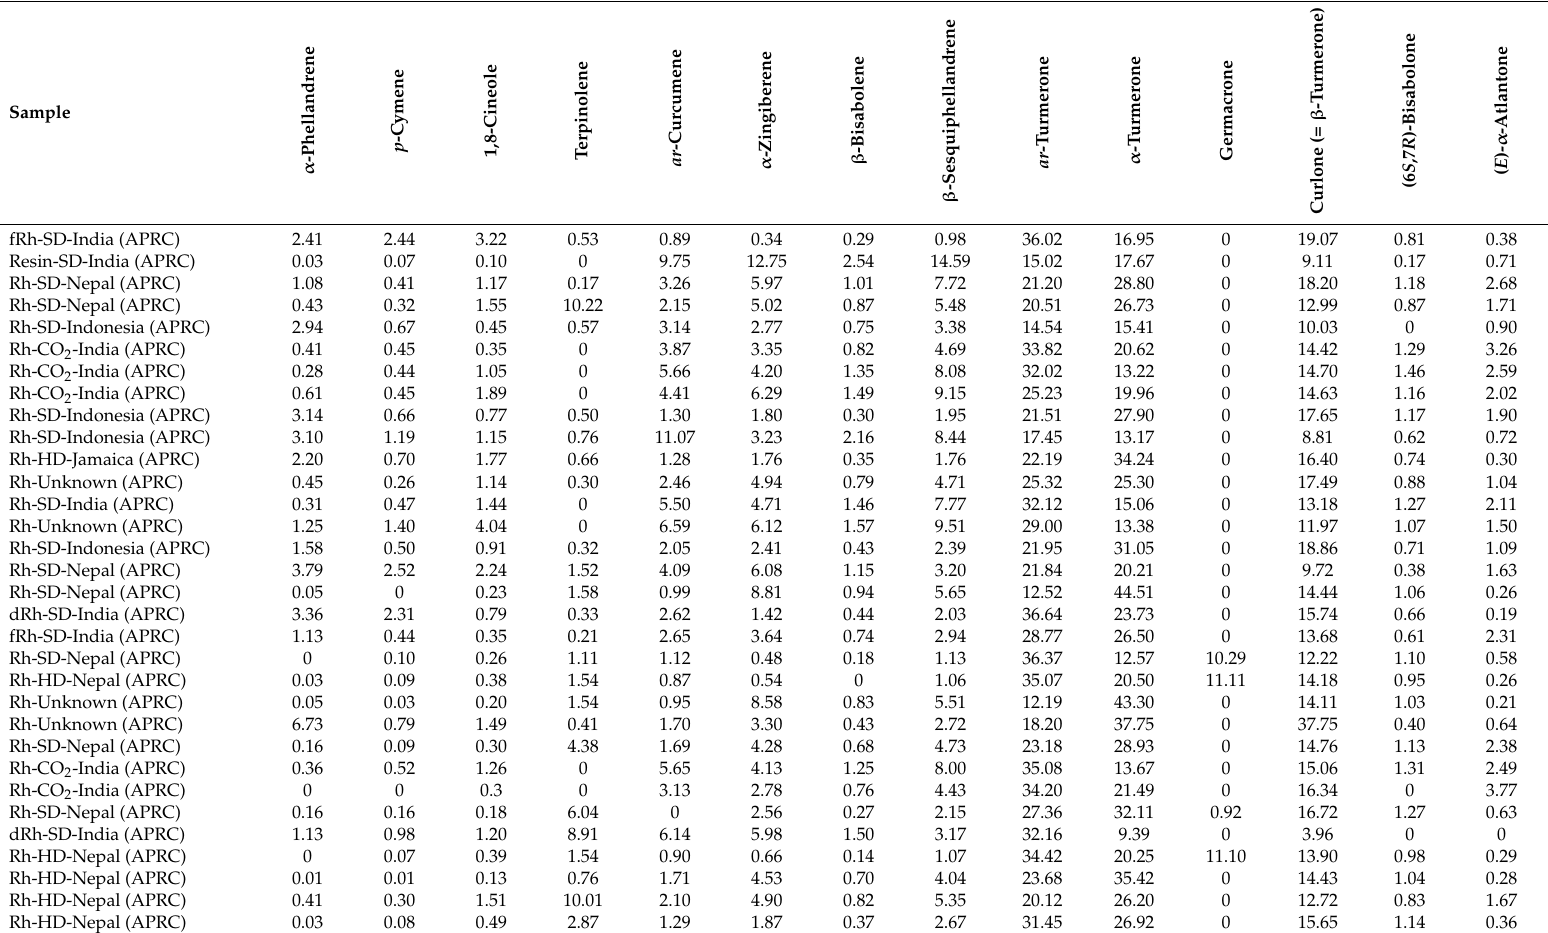
Table 1. Chemical compositions (major components) of Curcuma longa rhizome volatile